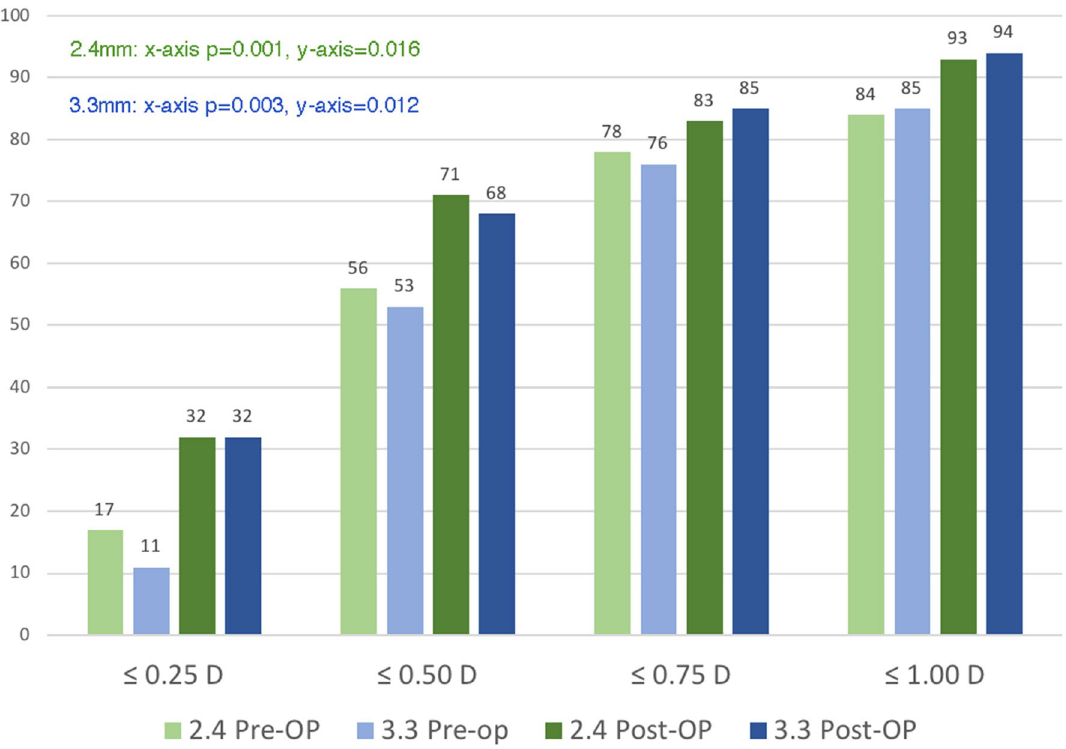
Figure 1. Distribution of astigmatism prediction error. Using postoperative keratometrics for calculation reduces prediction error compared with using preoperative keratometrics considering surgically induced astigmatism. More than 90% of the patients have a prediction error of < 1.0 D with postoperative keratometrics. This trend is observed in both the 2.4- and 3.3-mm groups. D diopter, pre-op preoperative, post-op postoperative. Parameter(D) 2.4